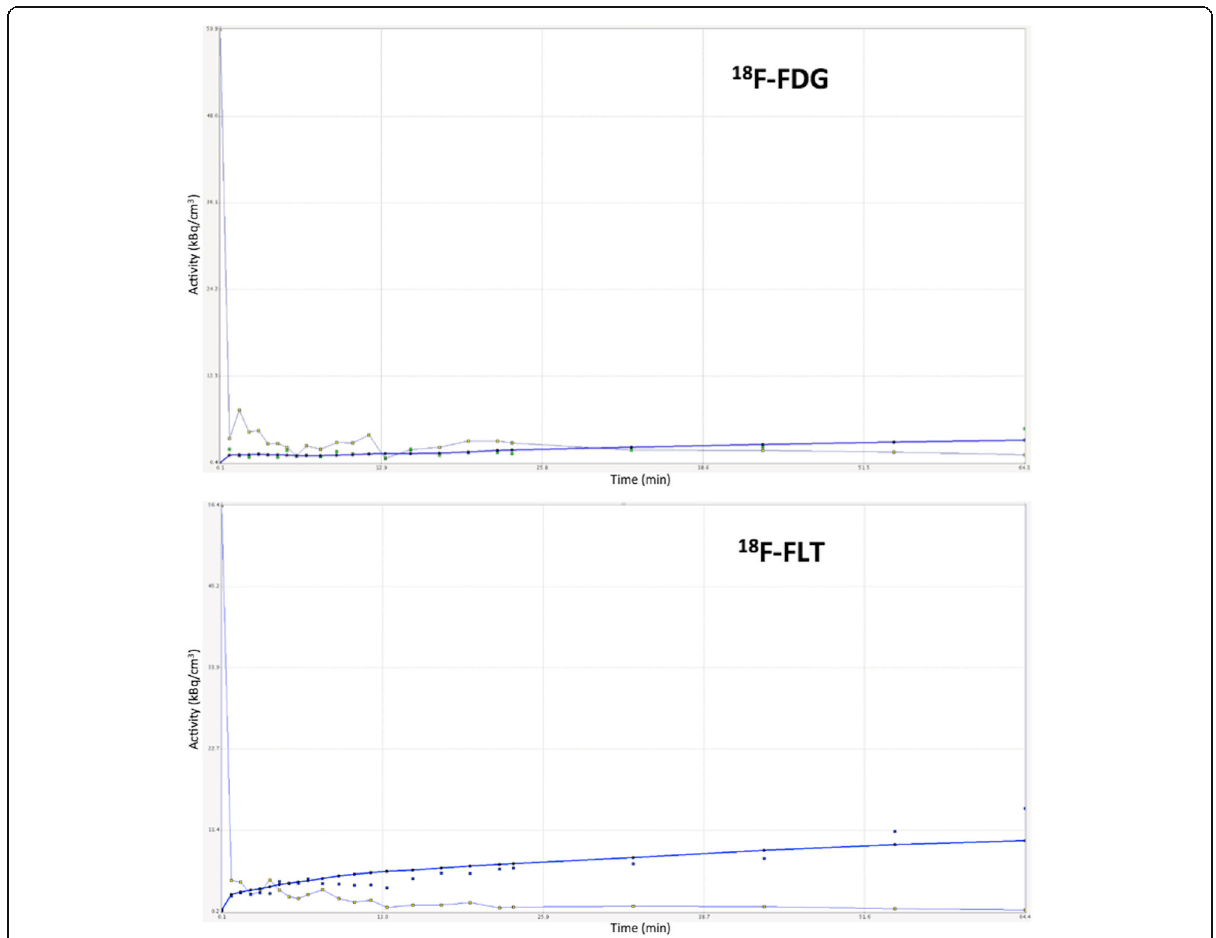
Fig. 6 Time activity curves depicting 18 F-FDG (upper row) and 18 F-FLT (lower row) concentration during the 60 min of dynamic PET acquisition. The curves are derived from a MM lesion in the os ilium (curve with blue dots) and from the common iliac artery (curve with gold dots) in the respective VOIs. The curves show that both tracers accumulate increasingly in the MM